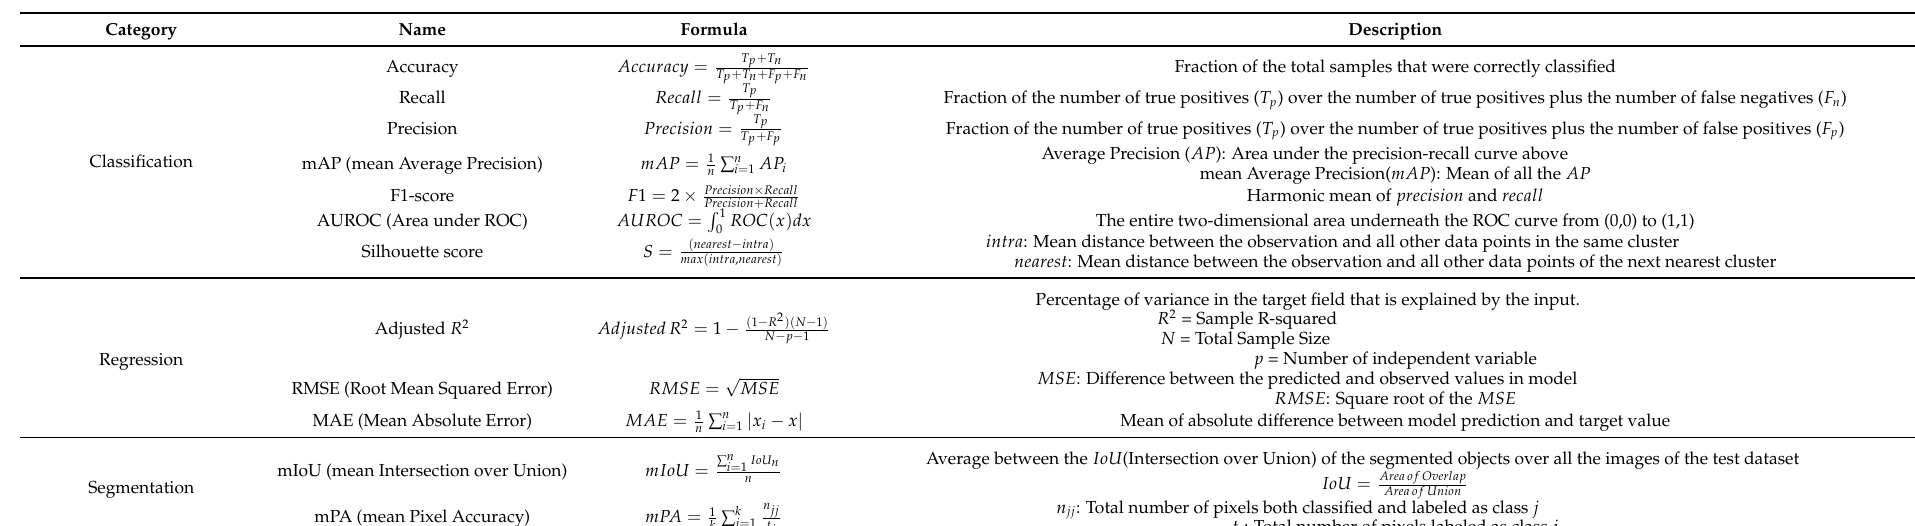
Table A2. Performance